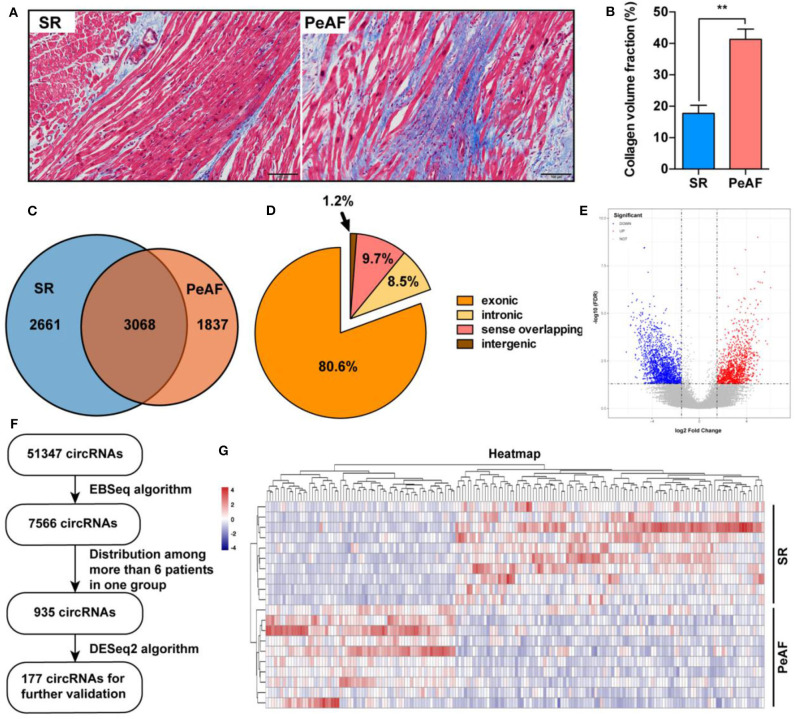
Expression profiles of circRNAs between SR and PeAF group. (A) Masson's staining of LAA in SR and PeAF patient. (B) Measurement of collagen volume fraction between SR and PeAF LAA tissues (17.7 vs. 41.3%, P < 0.01). (C) Venn diagram of differentially expressed circRNAs between SR and PeAF group. (D) Proportion of different types of circRNAs of RNA-Seq. (E) Volcano plot of differentially expressed circRNAs, red means upregulation, blue means downregulation. (F) Filter strategy diagram of differentially expressed circRNAs. (G) Heatmap of 177 differently expressed circRNAs between SR and PeAF group. *p < 0.05; **p < 0.01.